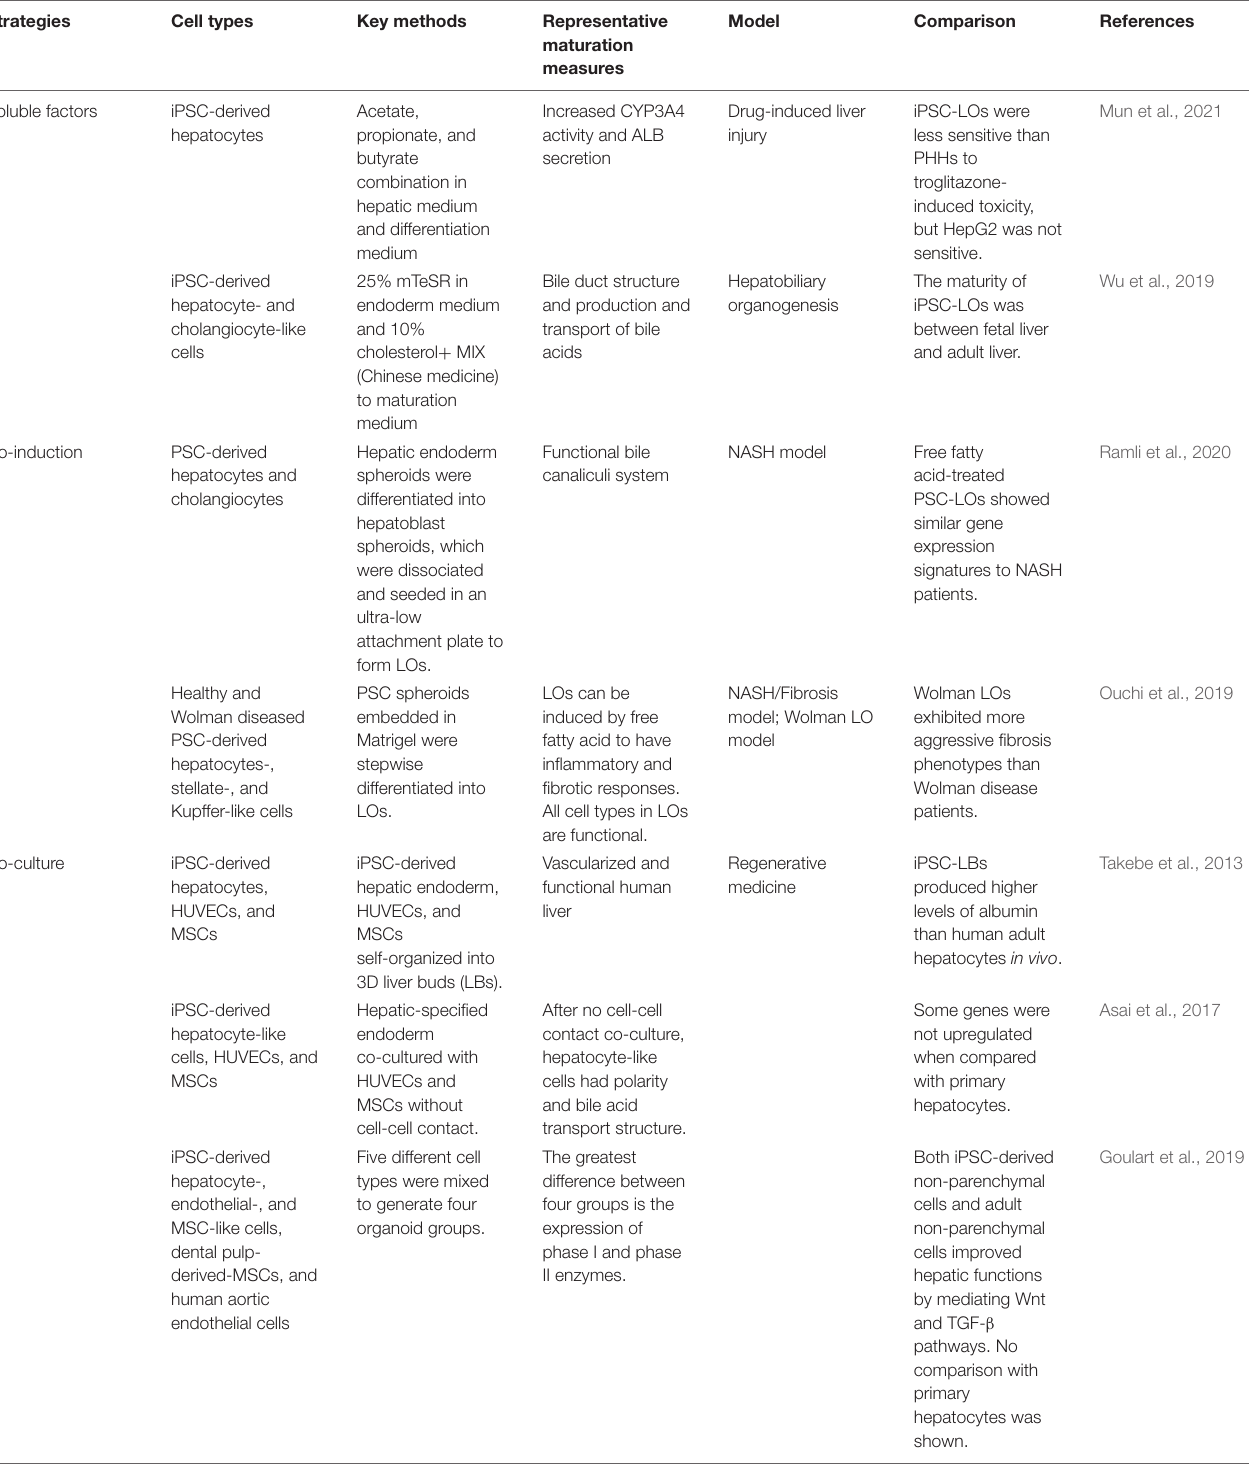
TABLE 2 | Strategies for improving maturity of human